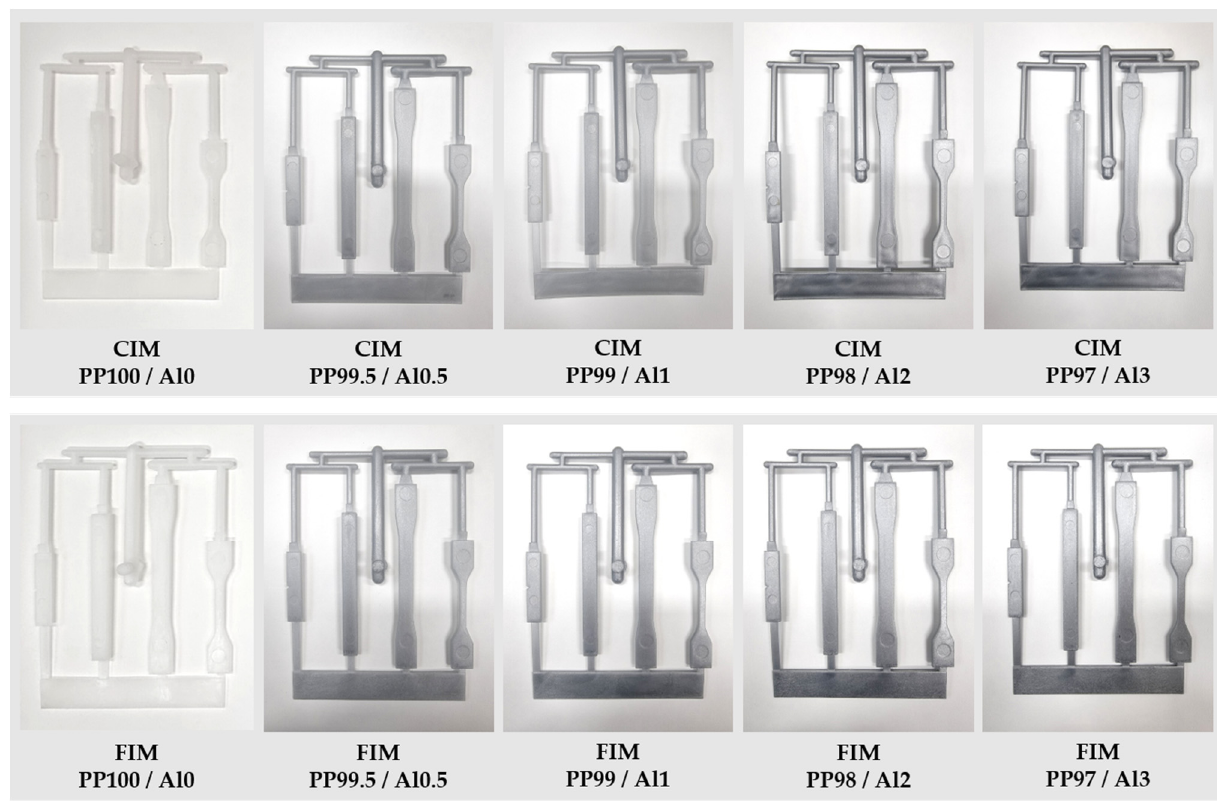
Figure 3. Appearance of conventional and foam injection specimens with different aluminum contents.